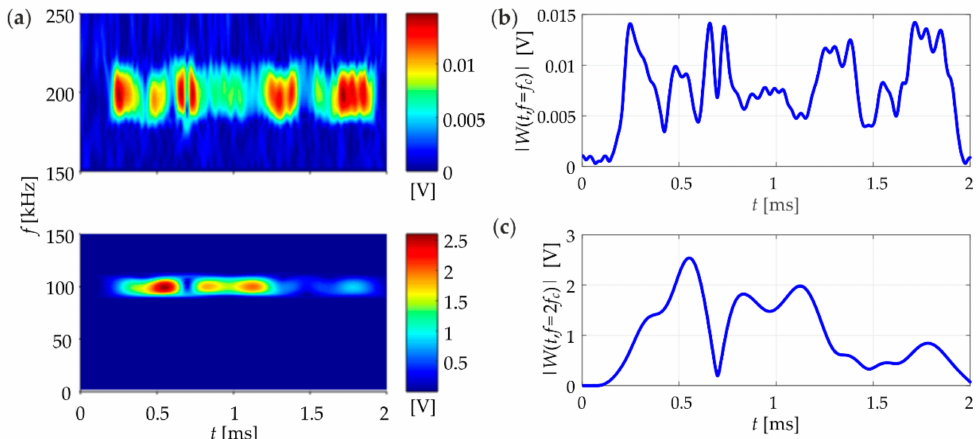
Figure 9. Wavelet transform modulus of an exemplary signal registered during the monitoring process: ( a ) time-frequency representation; ( b ) continuous wavelet transform (CWT) coefficient related to the fundamental frequency; and ( c ) CWT coefficient related to the second harmonic component.